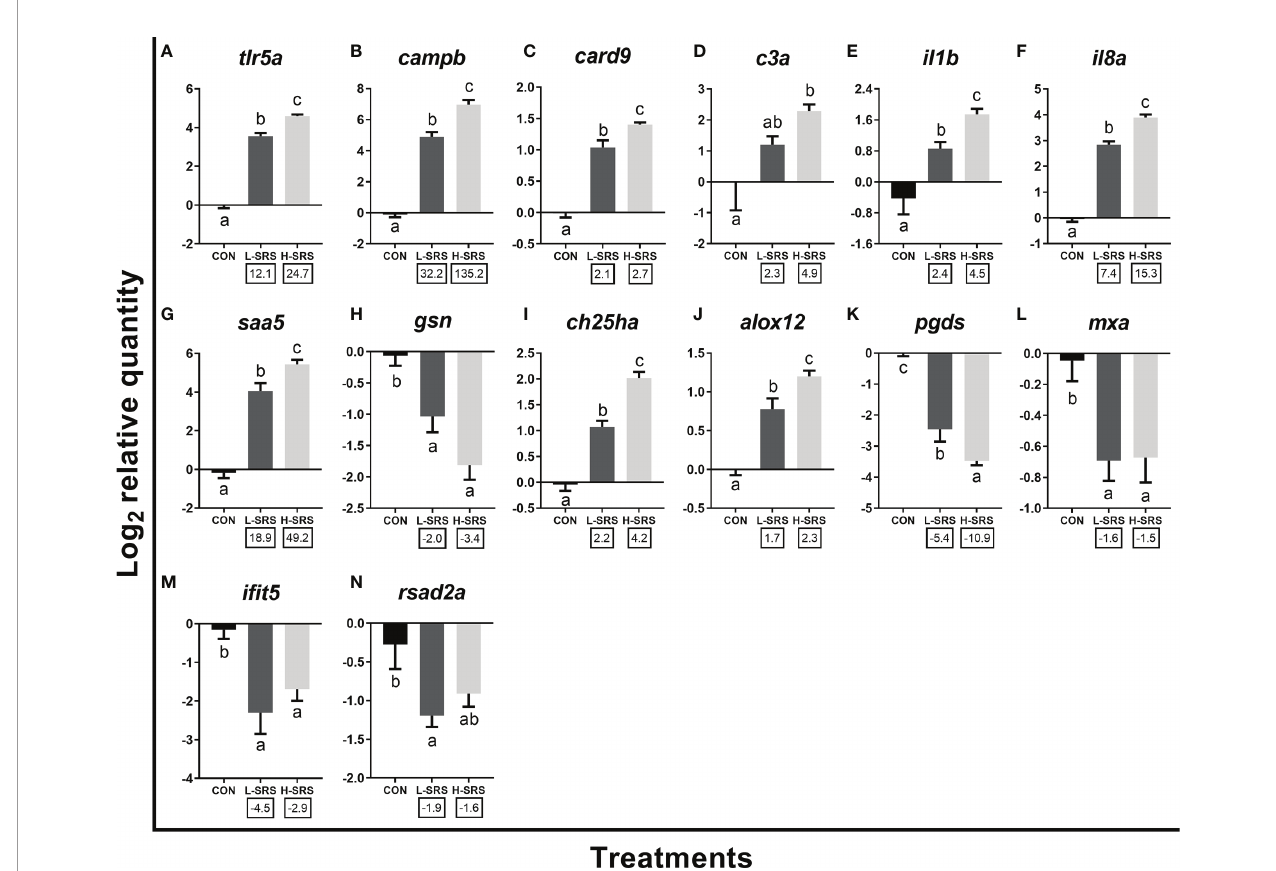
FIGURE 6 | qPCR analyses of P. salmonis -responsive genes involved in the innate immune response. Fish with lower (L-SRS; n = 11) and higher (H-SRS; n = 17) level of P. salmonis infection at 21 days post-injection (DPI) as well as time-matched control (CON; n = 9) were used for qPCR con fi rmation. Average log 2 RQs with SE bars are plotted. Different letters represent the signi fi cant differences among treatments ( p < 0.05) with fold-change relative to control indicated below the x-axis. For qPCR fold-change calculation, overall fold up-regulation was calculated as 2 A-B , where A is the mean of log 2 RQ from the L-SRS or H-SRS groups, and B is the mean of log 2 RQ from the CON group. For down-regulated transcripts, fold-change values were further inverted (-1/fold-change). (A) toll-like receptor 5a ; (B) cathelicidin antimicrobial peptide b ; (C) caspase recruitment domain-containing protein 9 ; (D) complement c3a ; (E) interleukin 1 beta ; (F) interleukin 8a (alias C-X-C motif chemokine ligand 8a ); (G) serum amyloid A-5 protein ; (H) gelsolin precursor ; (I) cholesterol 25-hydroxylase a ; (J) arachidonate 12-lipoxygenase, 12S-type ; (K) lipocalin-type prostaglandin D synthase ; (L) interferon-induced GTP-binding protein Mx a ; (M) interferon-induced protein with tetratricopeptide repeats 5 ; (N) radical S-adenosyl methionine domain-containing protein 2a